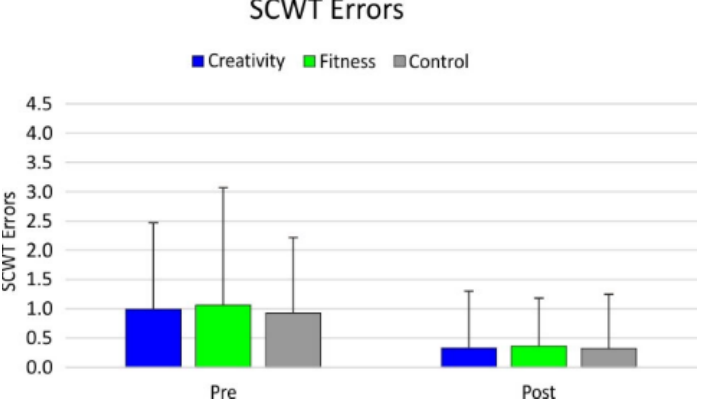
Figure 3. SCWT (errors) results.